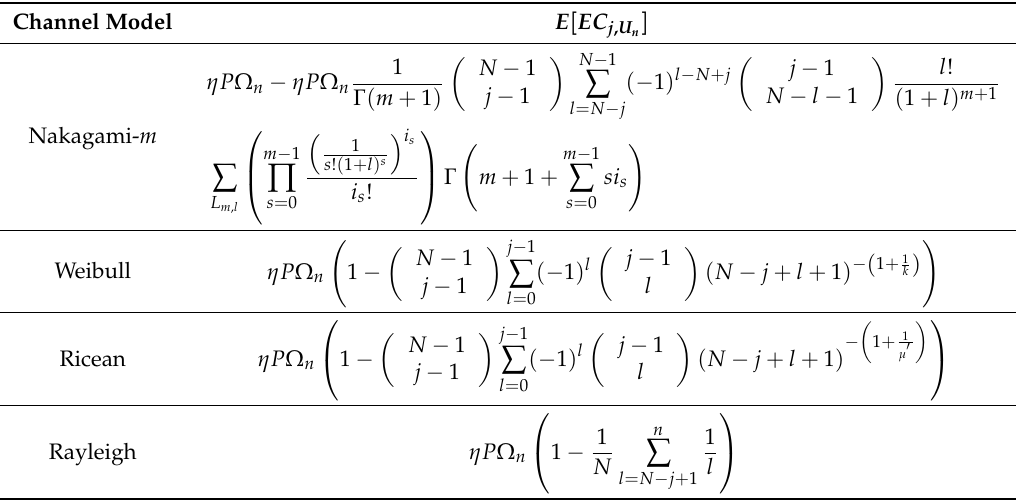
Table 7. ACE of a single user obtained by